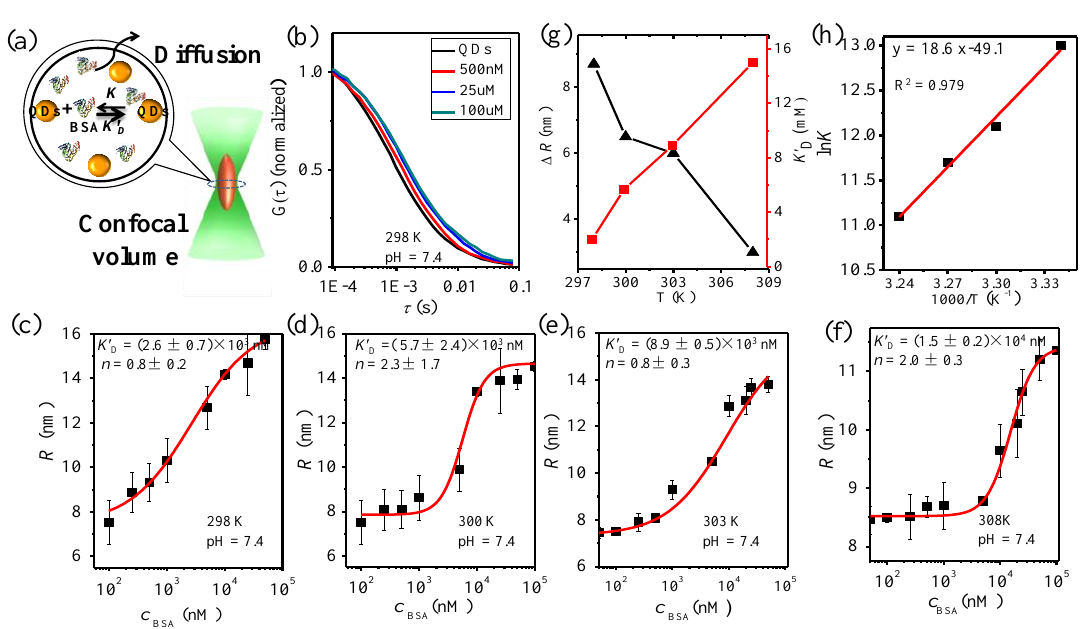
Figure 2. ( a ) Scheme of FCS system; ( b ) FCS correlation curves; ( c – f ) hydrodynamic radii of QDs-COOH at different BSA concentrations (pH = 7.4) at different temperatures (298 K, 300 K, 303 K, and 308 K); ( g ) Plot of K′ D (red line), ∆ R (black line) versus temperature; and ( h ) the plot of ln K against 1/T. Table 2. Summary of measured K ′ D , ∆ R , ln K , Hill coefficient n , and ∆ H , ∆ S , and ∆ G for BSA and QDs binding at different pH (6.0, 7.4, and 9.0).